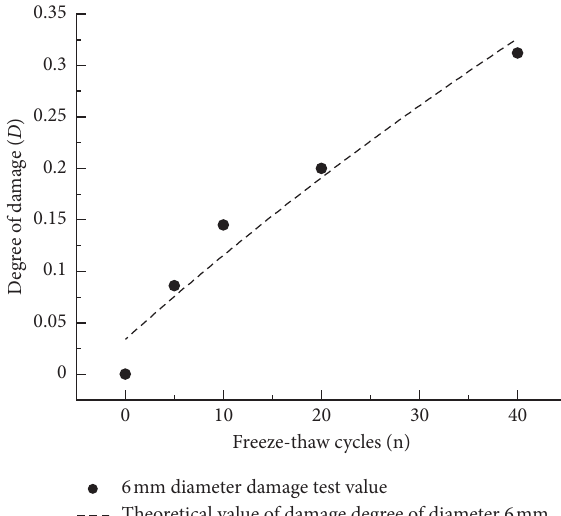
Figure 14: Yellow sandstone damage curve of different freeze-thaw cycles (aperture 6mm).